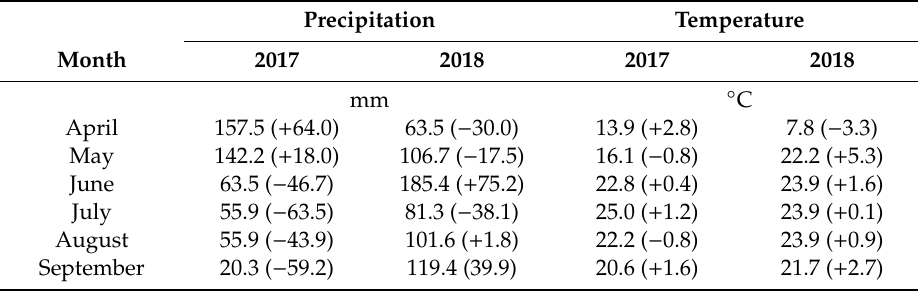
Table 2. Precipitation and temperature during the production season at Champaign, IL in 2017 and 2018 compared to the 30-year average. Values were obtained from the U.S. National Oceanic and Atmospheric Administration, and values in parentheses are the deviations from the 30-year